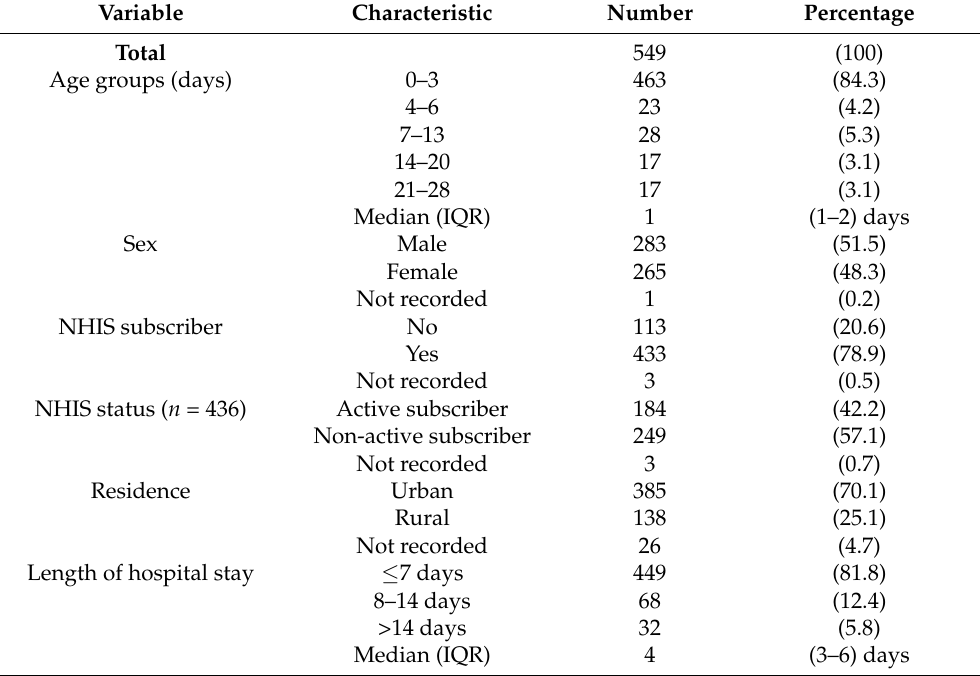
Table 1. Socio-demographic characteristics of neonates admitted with suspected sepsis at Komfo Anokye Teaching Hospital, Ghana, between January 2021 and December 2021. Variable